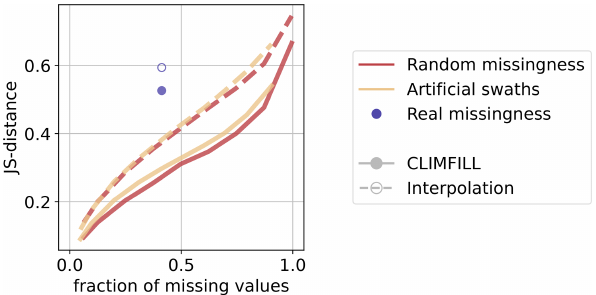
Figure 9. Median performance of gap filling with CLIMFILL and univariate interpolation on different missingness patterns and frac- tions of missingness expressed in JS distance (for more details, see Sect. 4.2) per variable. Gap filling for random missingness and ar- tificial swaths is executed for a range of fractions of missing values and is denoted as a line, while real missingness is only one case and is depicted as a point. The metrics are calculated over each time step for all non-satellite-observable values of grid points on land, and the median of all land points is also